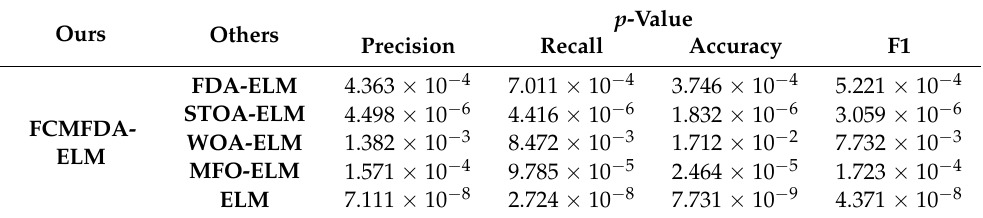
Table 9. T -test results of FCMFDA-ELM and other algorithms on four indicators (Fish4Knowledge).